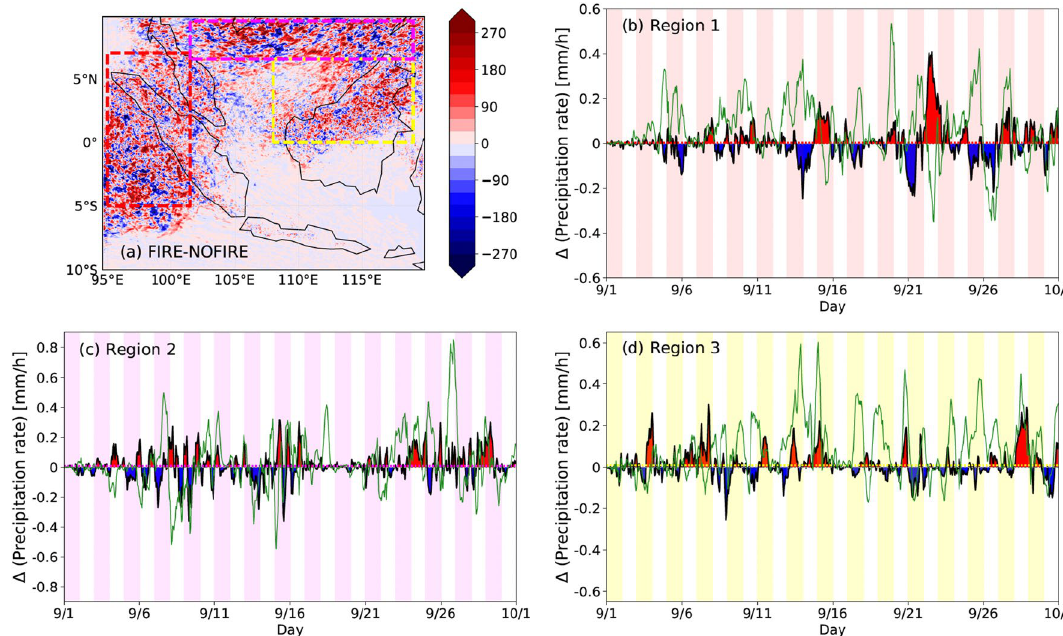
Figure 2. ( a ) Difference (FIRE-NOFIRE) in accumulated precipitation (mm) over the month of September. ( b – d ) Time series of regional mean precipitation rate differences (FIRE-NOFIRE) in ( b ) Region 1, ( c ) Region 2, and ( d ) Region 3. An equivalent figure for the CHEM runs can be found in TW22. The green lines show the equivalent values from the CHEM runs.